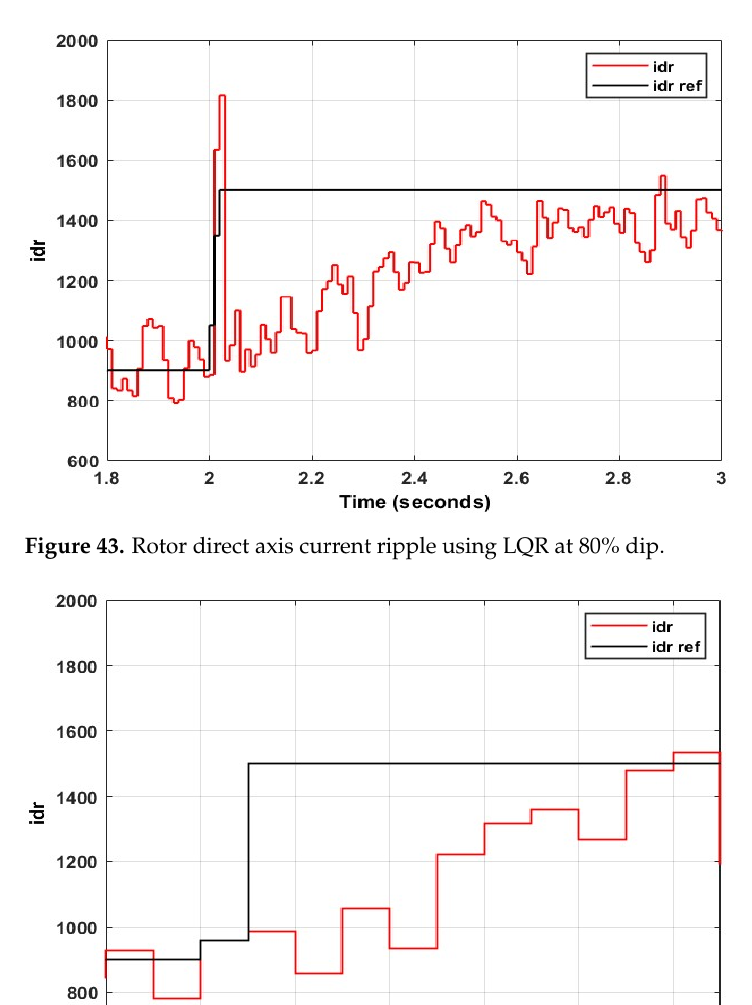
Figure 42. DC voltage transient using LQR at 80% dip.